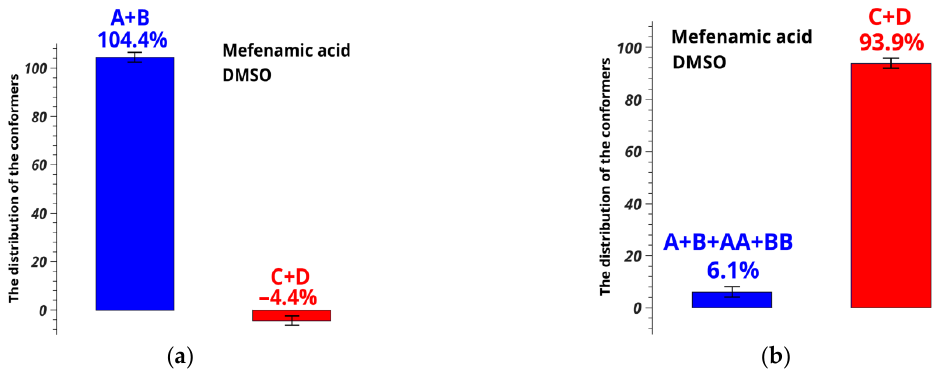
Figure 9. Distribution of conformers of MFA in DMSO-d 6 calculated from the observed conformation-dependent distance OH-H6 ( a ) without and ( b ) allowing for the existence of additional conformers AA and BB. Figure 9a is a duplicate of Figure 7a for comparison.